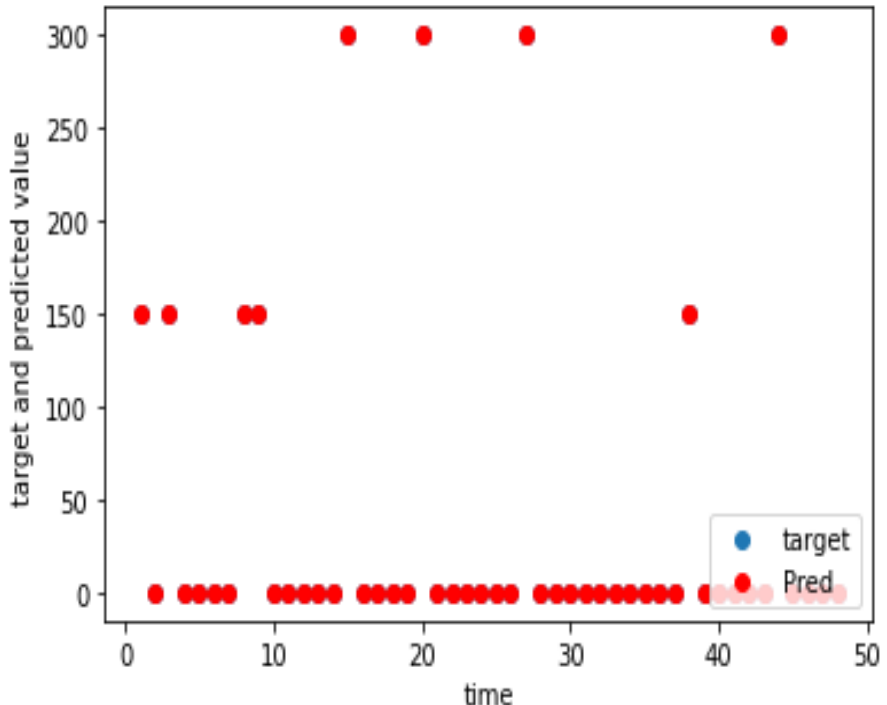
Figure 13. Charging demand prediction of a weekday for Tuomarilankallio.